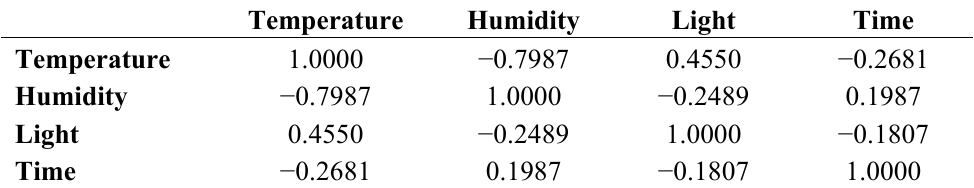
Table 4. Results of the correlation